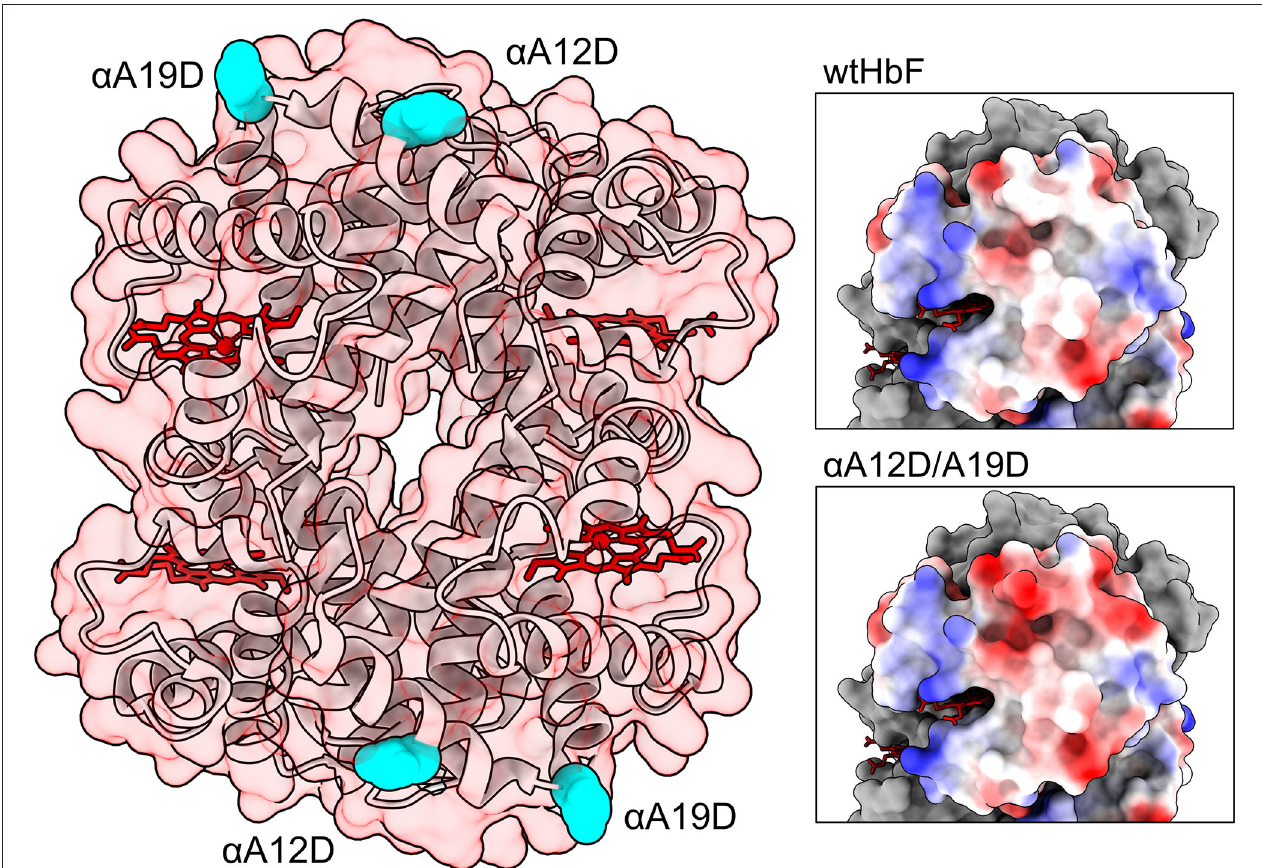
FIGURE 1 | Structure of HbF (PDB code: 1FDH; Frier and Perutz, 1977). To the left the entire protein structure is shown as ribbons, with a transparent red-tinted surface, and heme groups are colored in red. Mutation sites are depicted as cyan spheres. Panels to the right show the surface of the α -subunit colored by electrostatic potential (red for negative, blue for positive, and white for neutral). The upper right panel show unmodified wild-type HbF while the lower panel show the double mutated structure α A12D/A19D. The figures were created in the UCSF Chimera and ChimeraX molecular visualization programs (Pettersen et al., 2004; Goddard et al., 2018). Mutations were introduced in the model with the swapaa command in the Chimera software.